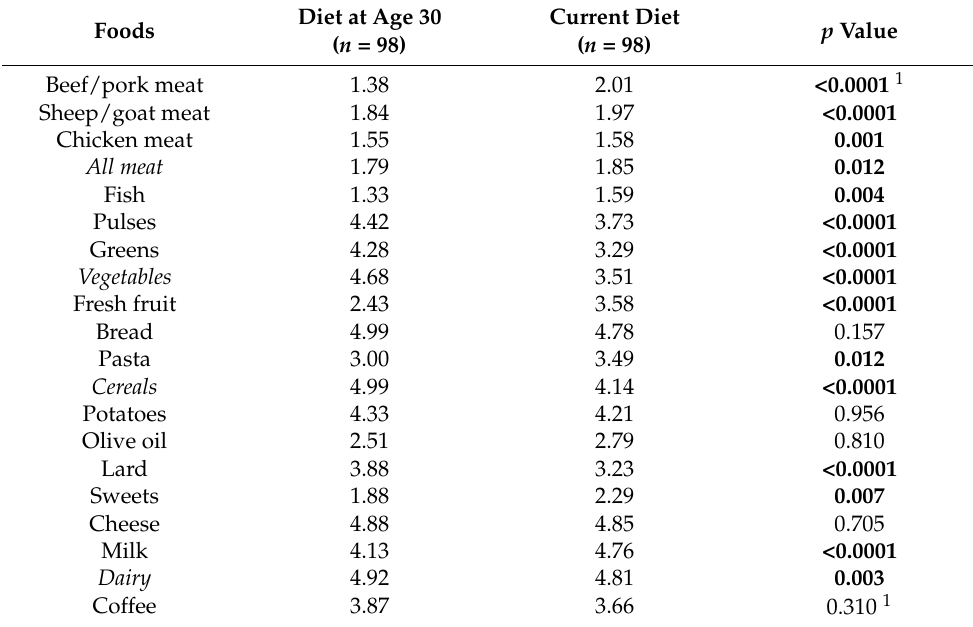
Table 2. Food frequency consumption before (at the age of 30 years) and after (currently) the nutrition